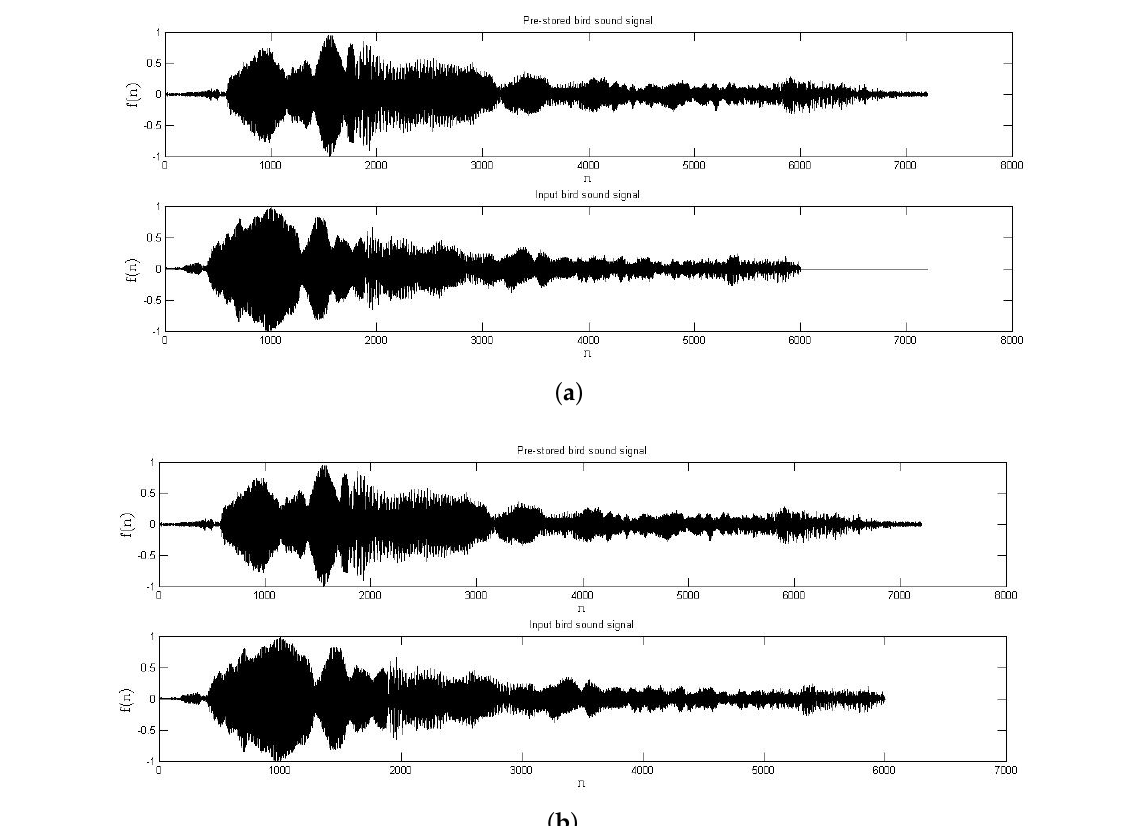
Figure 3. Example of an audio record of a bird vocalization ( a ) before and ( b ) after time domain